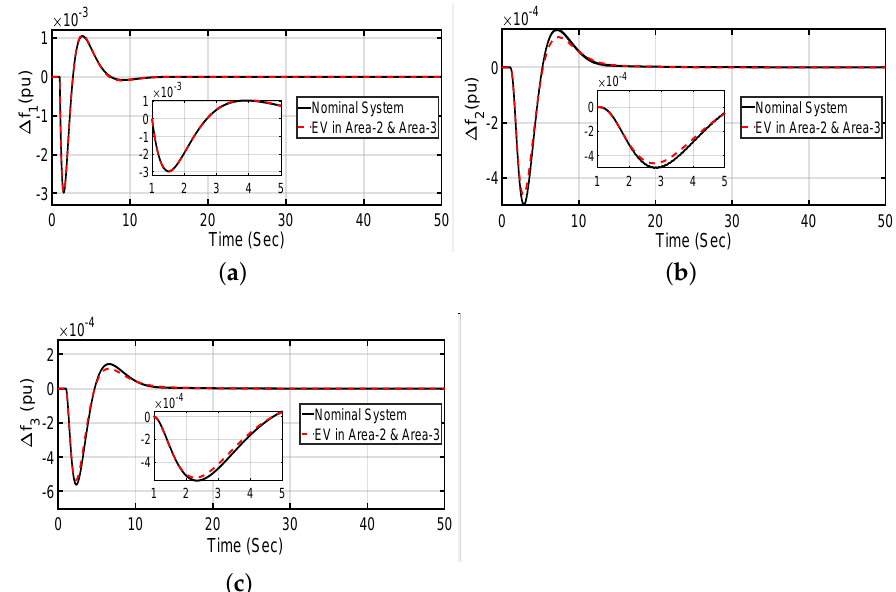
Figure 12. Response comparison when EVs are connected in Area 2 and Area 3 only. ( a ) ∆ f 1 ; ( b ) ∆ f 2 ; ( c ) ∆ f 3